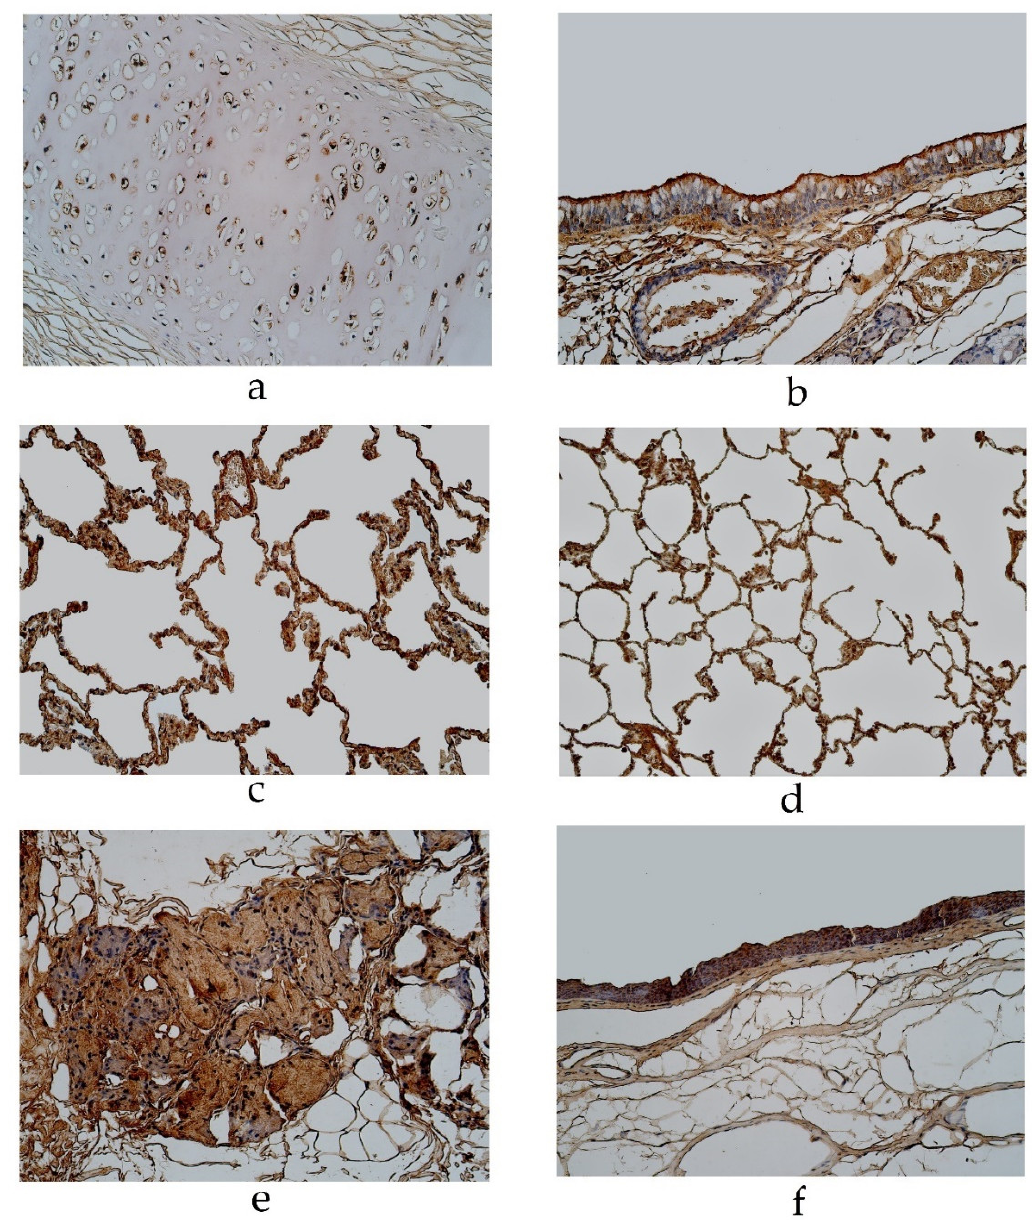
Figure 4. Immunohistochemical micrographs of the lungs. ( a ) Moderate to numerous number of IL-6 positive structures in the cartilage of a 94-year-old male in the pseudostratified ciliated epithelium group. IL-6 IMH, X200; ( b ) A few IL-6 positive bronchial epithelial cells observed in a 19-year-old male of the group with the pseudostratified ciliated epithelium. IL-6 IMH, X200; ( c ) A moderate number of IL-6 positive cells in the alveolar epithelium of a 95-year-old female in the pseudostratified ciliated epithelium group. IL-6 IMH, X200; ( d ) A moderate number of IL-6 positive alveolar epithelium cells observed in a 25-year-old male of the group with the stratified squamous epithelium group. IL-6 IMH, X200; ( e ) Moderate number of positive IL-6 cells in the glands of a 23-year-old male in the stratified squamous epithelium group. IL-6 IMH, X200; ( f ) Moderate number of IL-6 positive bronchial epithelial cells in a 46-year-old male of the stratified squamous epithelium group. IL-6 IMH, X200.